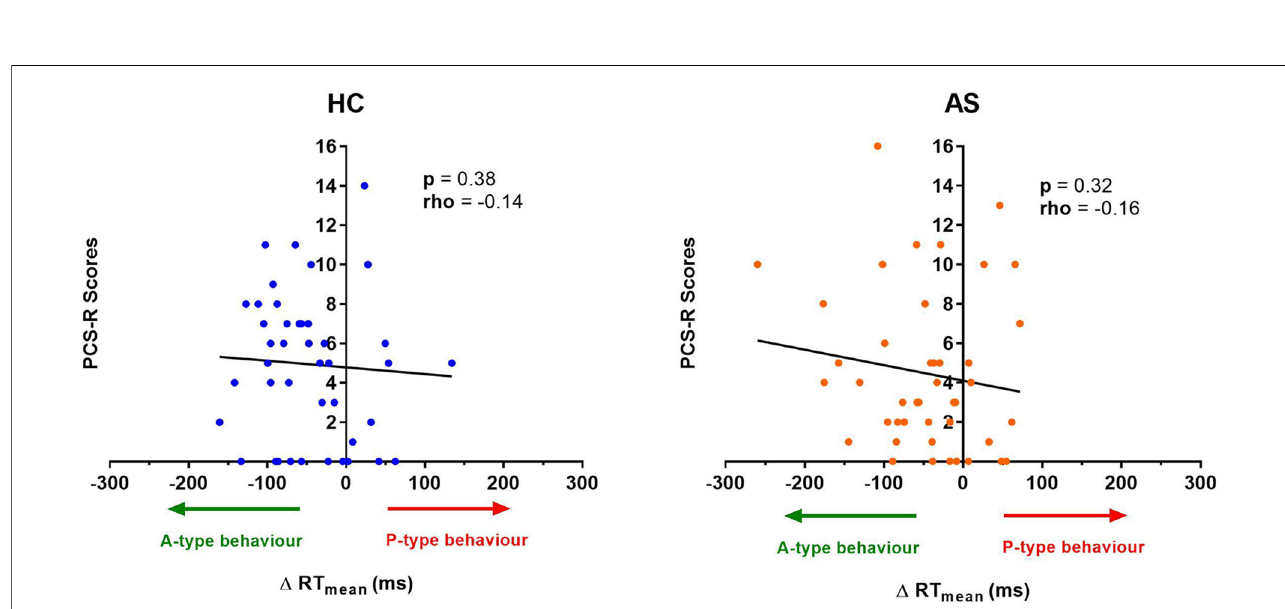
FIGURE 8 Relationship between an individual ’ s pain rumination score and the effect of pain on their task reaction time (RT). No signi fi cant correlation was found between the pain rumination scores (derived from the rumination subscale of the pain catastrophizing scale) (PCS-R) and the Δ RT mean in the healthy controls (HCs) or for the ankylosing spondylitis (AS) group. The HCs are represented by the blue dots. The AS group is represented by the orange dots. A-type behavior is represented by a negative Δ RT mean value (values that are on the left side of the horizontal axis). P-type behavior is represented by a positive Δ RT mean value (values that are on the right side of the horizontal axis).